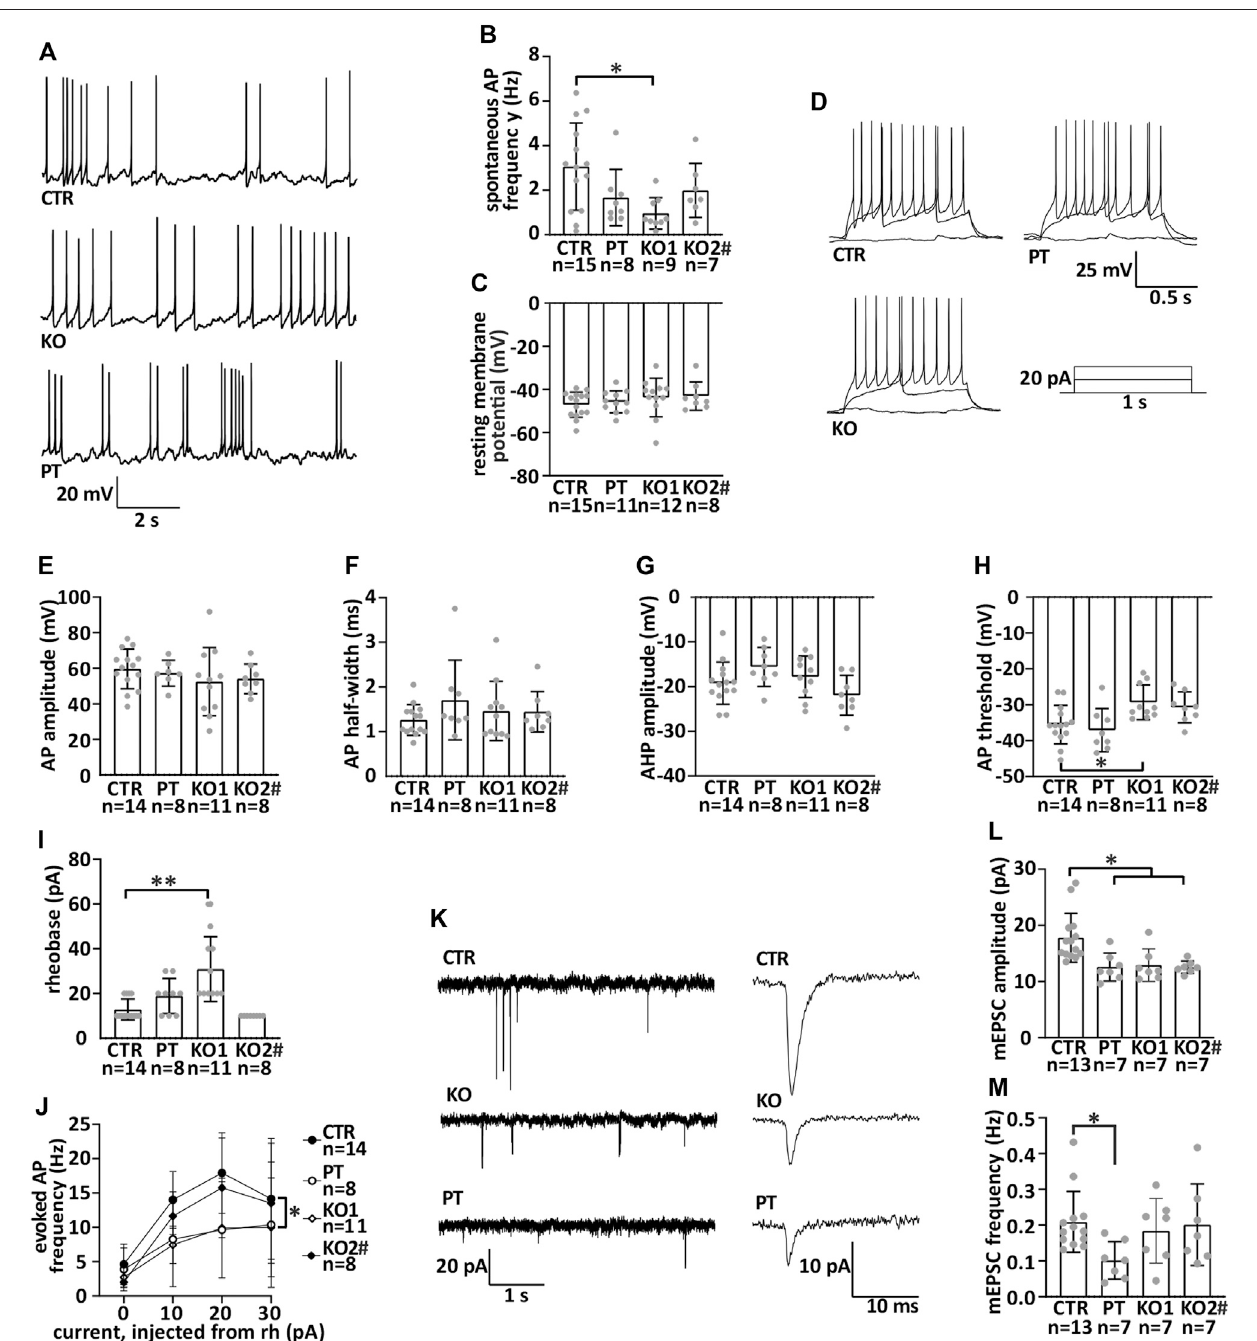
FIGURE 4 | iPSC-MN lacking NFL differentiate into functional motor neurons with reduced miniature excitatory postsynaptic current amplitude. Motor neuron electrophysiological characteristics were measured by whole cell patch-clamp during the seventh week of differentiation. (A) Example traces of spontaneous action potentials. (B) Frequency of spontaneous action potentials in current-clamp (CTR vs. KO1 multiple-comparison p = .0106). (C) Resting membrane potential. (D) Example traces of action potentials evoked by depolarization and a scheme of the depolarizing current injected. (E) Action potential amplitude. (F) Action potential half-width. (G) After-hyperpolarizing potential amplitude. (H) Action potential threshold (CTR vs. KO1 p = .0322). (I) Rheobase (CTR vs. KO1 p < .0001). (J) . Evoked action potential frequency ( p = .02, two-way repeated measures ANOVA). (K) Example traces of miniature excitatory post synaptic currents (mEPSCs) and averaged mEPSCs shown with the expanded time scale. (L) . Amplitude of mEPSC is reduced in iPSC-MNs lacking NFL (PT/KO1/KO2 vs. CTR p < .0170). (M) Frequency of mEPSC in iPSC-MNs. Data shown as individual measurements/neurons and mean with SD. * p < .05, ** p < .0001. One-way ANOVA followed with Dunnett ’ s multiple comparison post hoc test vs. CTR and two-way ANOVA followed with Tukey ’ s multiple comparison post hoc test for J. # indicates abnormal karyotype.